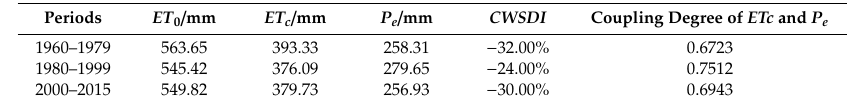
Table 2. Average ET 0 , ET C , P e , CWSDI , and coupling degree of ET c and P e during the maize growing seasons of 1960–2015 in the study area.